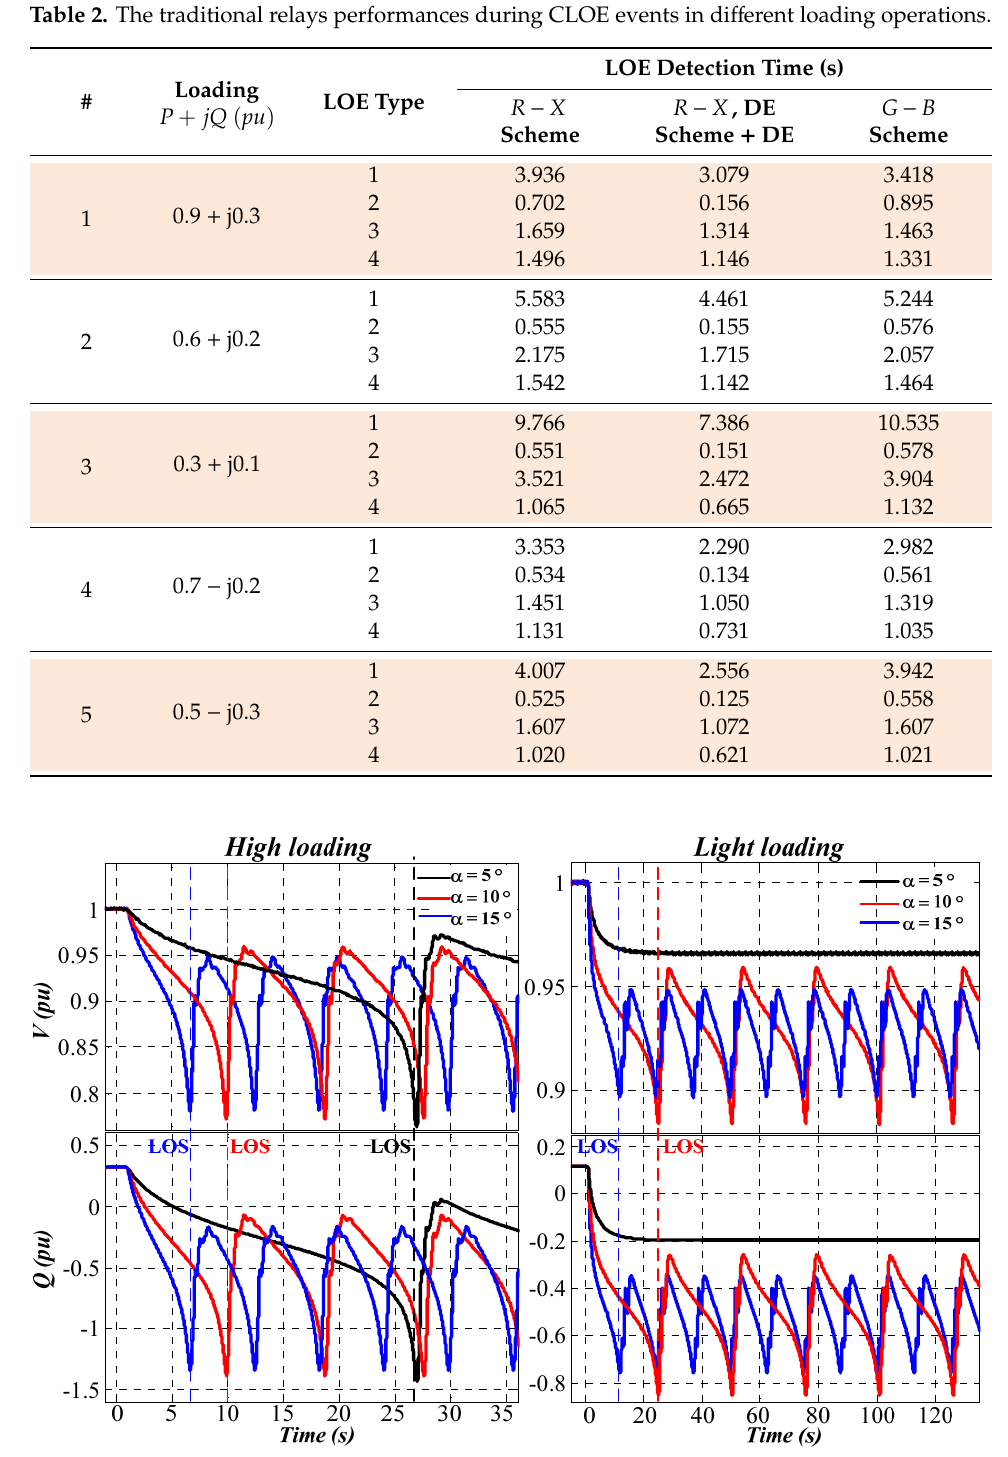
Figure 8. 𝑉 and 𝑄 variations during (PLOE failures in heavy loading (right column) and light Figure 8. V and Q variations during (PLOE failures in heavy loading (right column) and light loading loading (left column) conditions. (left column)